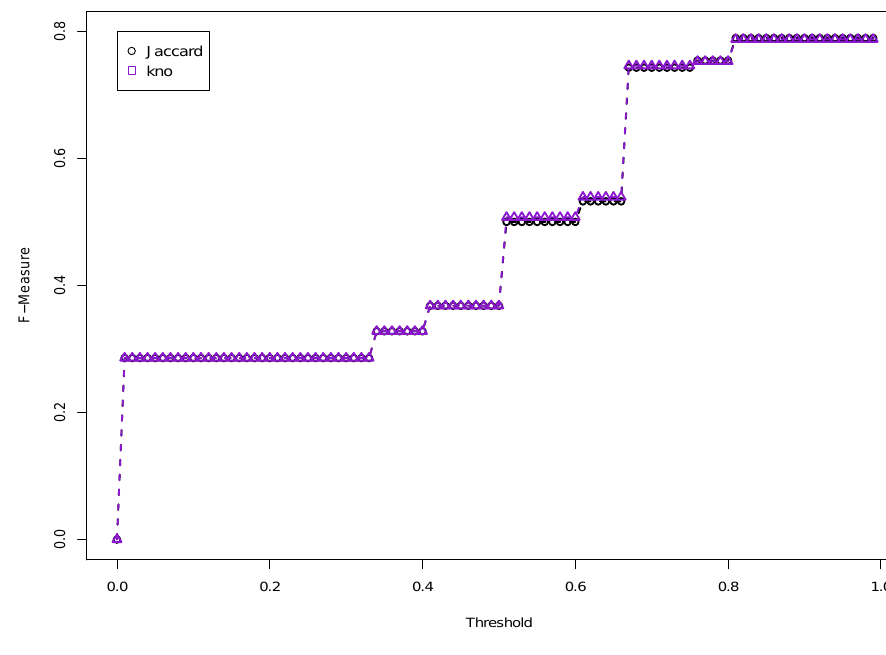
Figure 7. Semantic dissimilarity evaluation using word similarities derived from WordNet, using our proposed